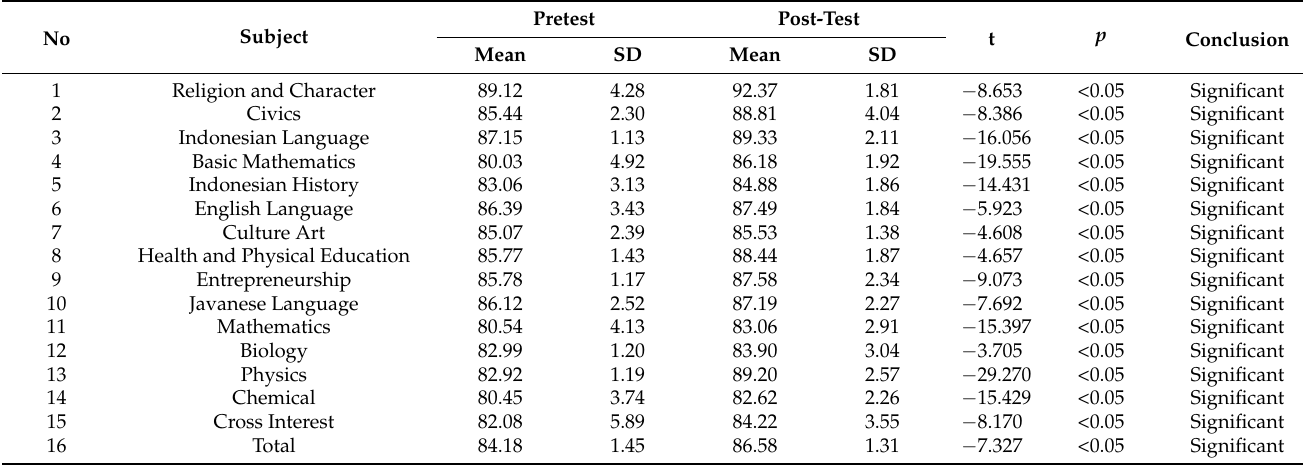
Table 1. The results of the analysis of the differences between students’ pretest and posttest before and after using the blended learning